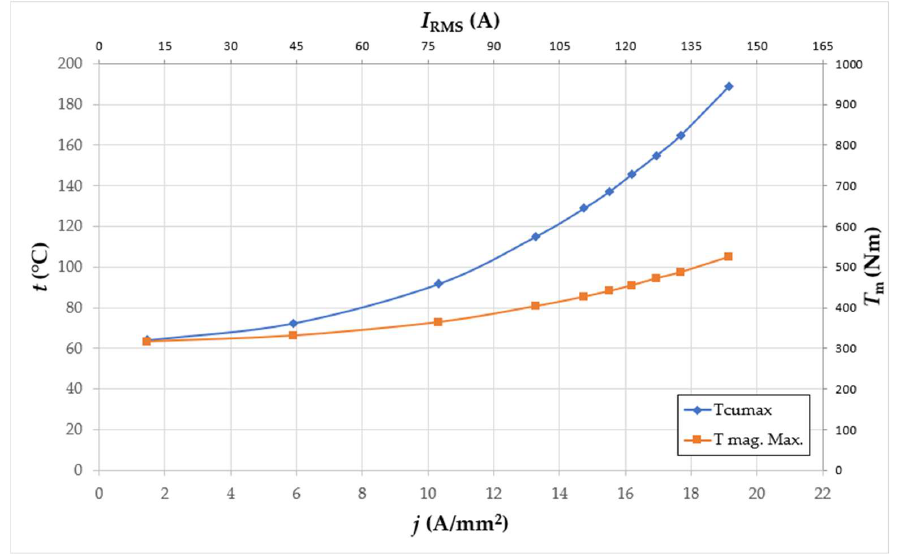
Figure 7. Calculated temperature characteristics of winding (hotspot) and magnet, calculated in the ANSYS Motr-CAD .